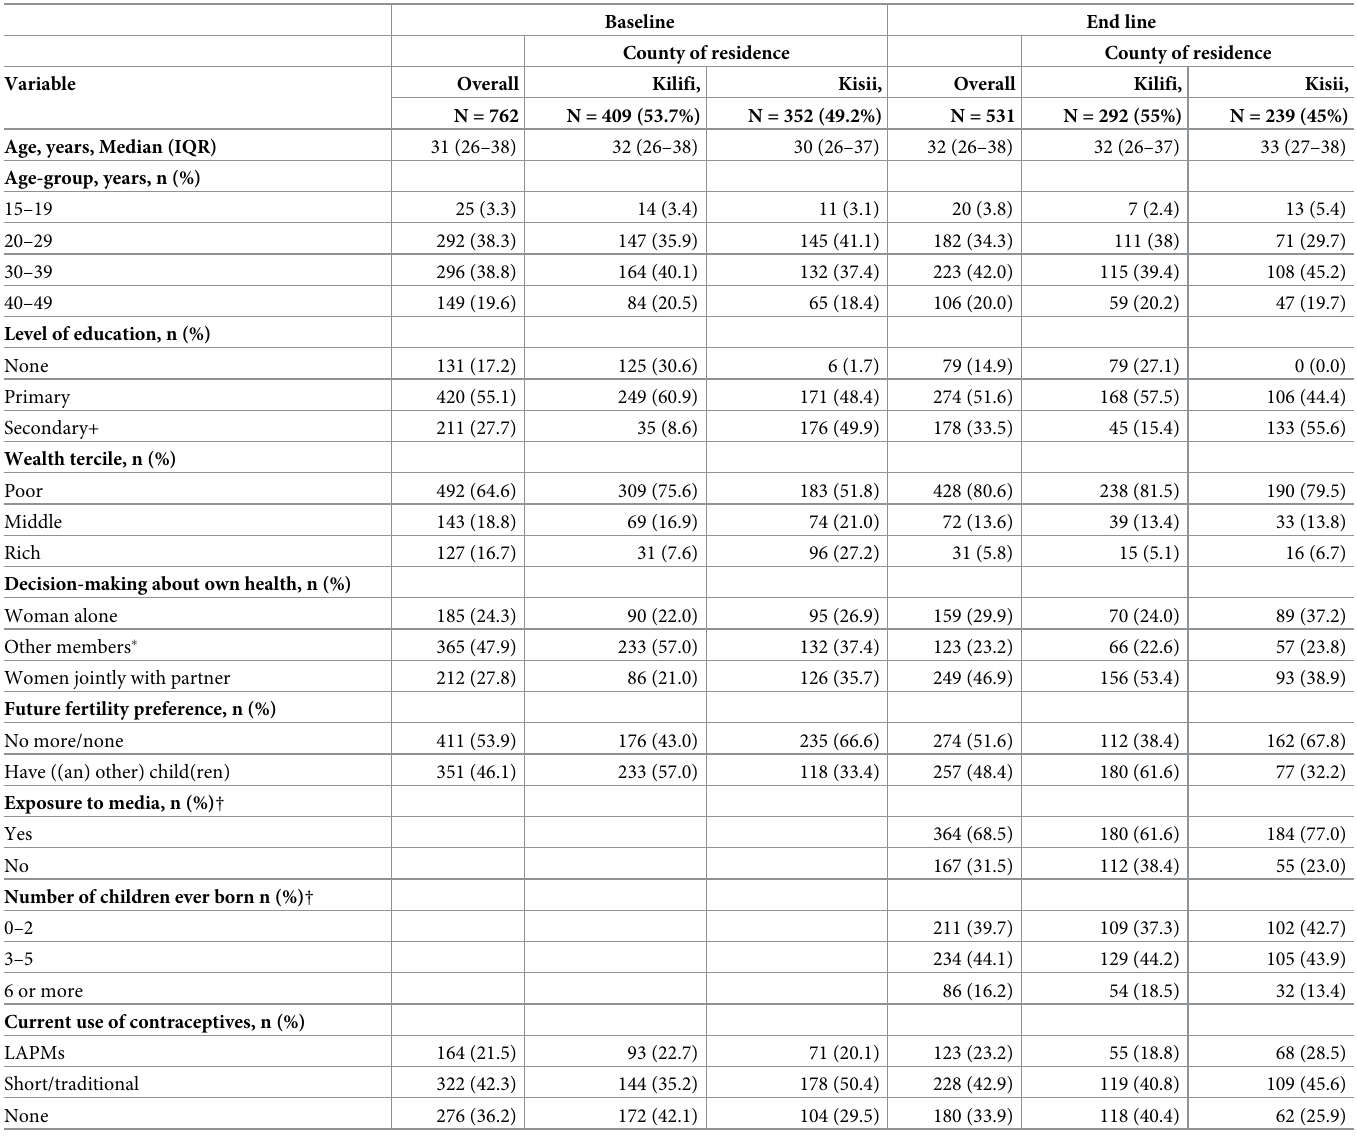
Table 1. Participants’ characteristics stratified by county of residence at baseline and end